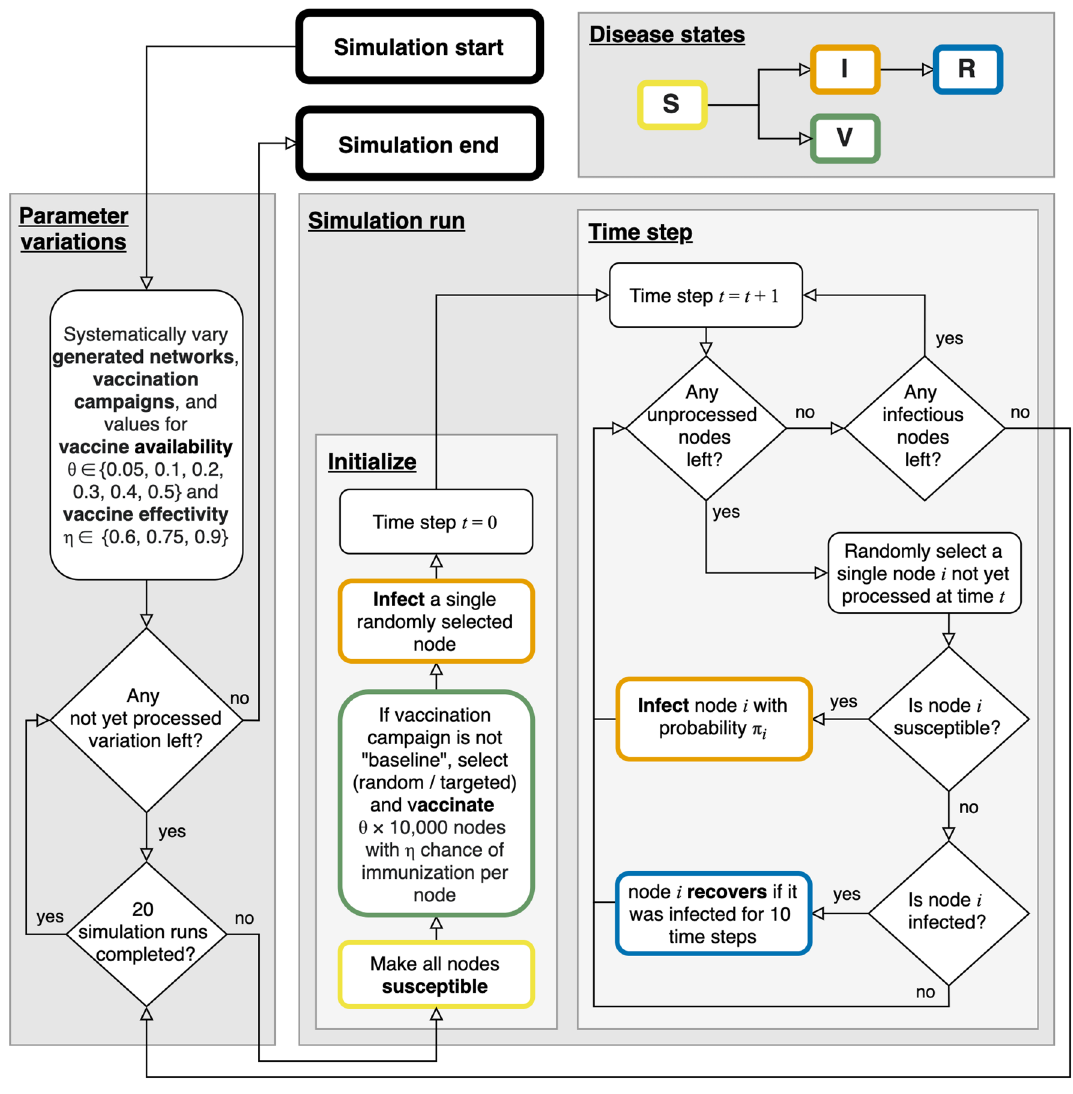
Figure 2. Flowchart of the